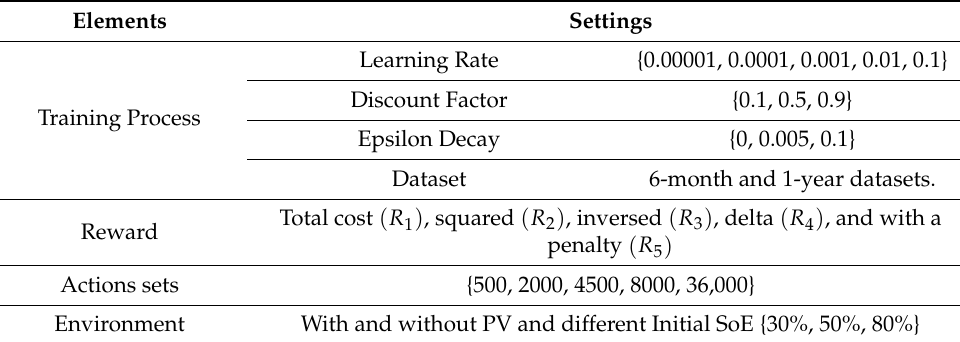
Table 5. Settings for each of the DRL elements considered in this